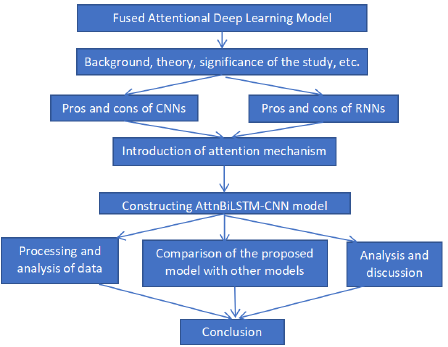
Figure 1. The research framework of this